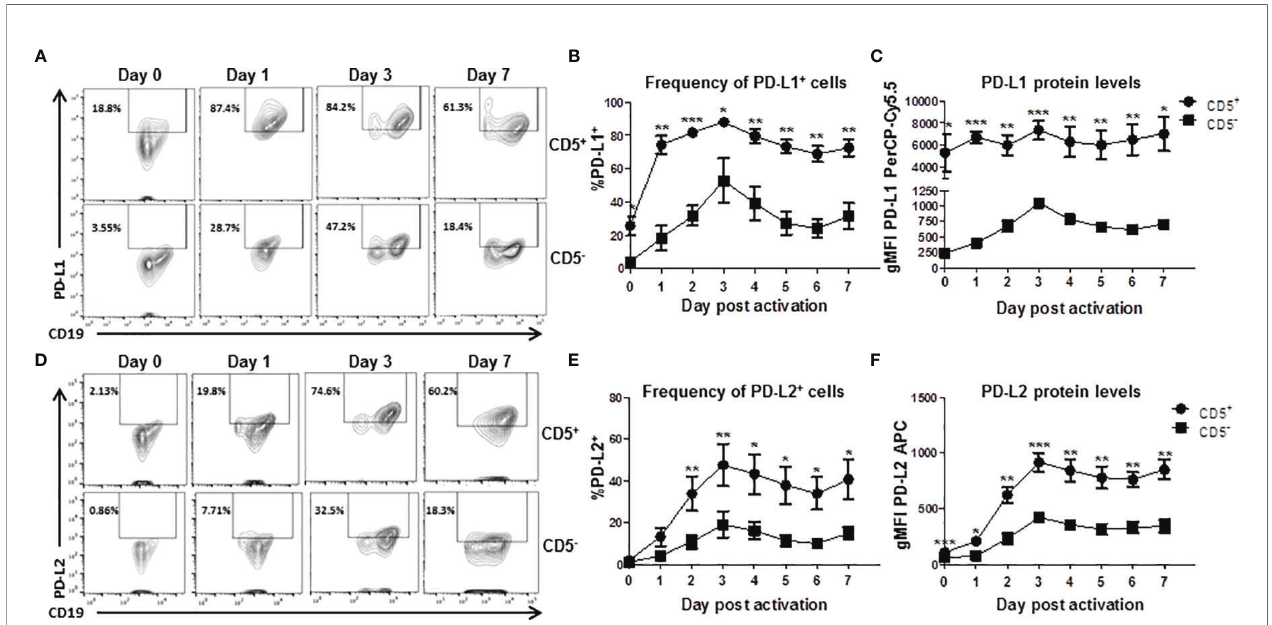
FIGURE 5 | Kinetics of PD-L1 and PD-L2 cell surface protein expression by activated human CD5 + ILB. Human CD5 +/- B cells were activated and cultured for 7 days as described previously and cells were collected daily and assessed for surface expression of either PD-L1 or PD-L2 by fl ow cytometry. (A) Representative PD-L1 fl ow plots at days 0, 1, 3, and 7; (B) Averaged frequency of PD-L1 + cells; (C) Averaged PD-L1 PerCP-Cy5.5 geometric mean fl uoresence intensity; (D) Representative PD-L2 fl ow plots at days 0, 1, 3, and 7; (E) Averaged frequency of PD-L2 + cells; and (F) Averaged PD-L2 APC geometric mean fl uoresence intensity. Determinations were made using B cells from 6 human donors (N = 6) across 3 independent experiments. Sign fi cant differences between CD5 +/- B cells were determined at each time point using a paired, two way t-test. Signi fi cant differences are indicated by * p < 0.05, ** p < 0.01, and *** p <